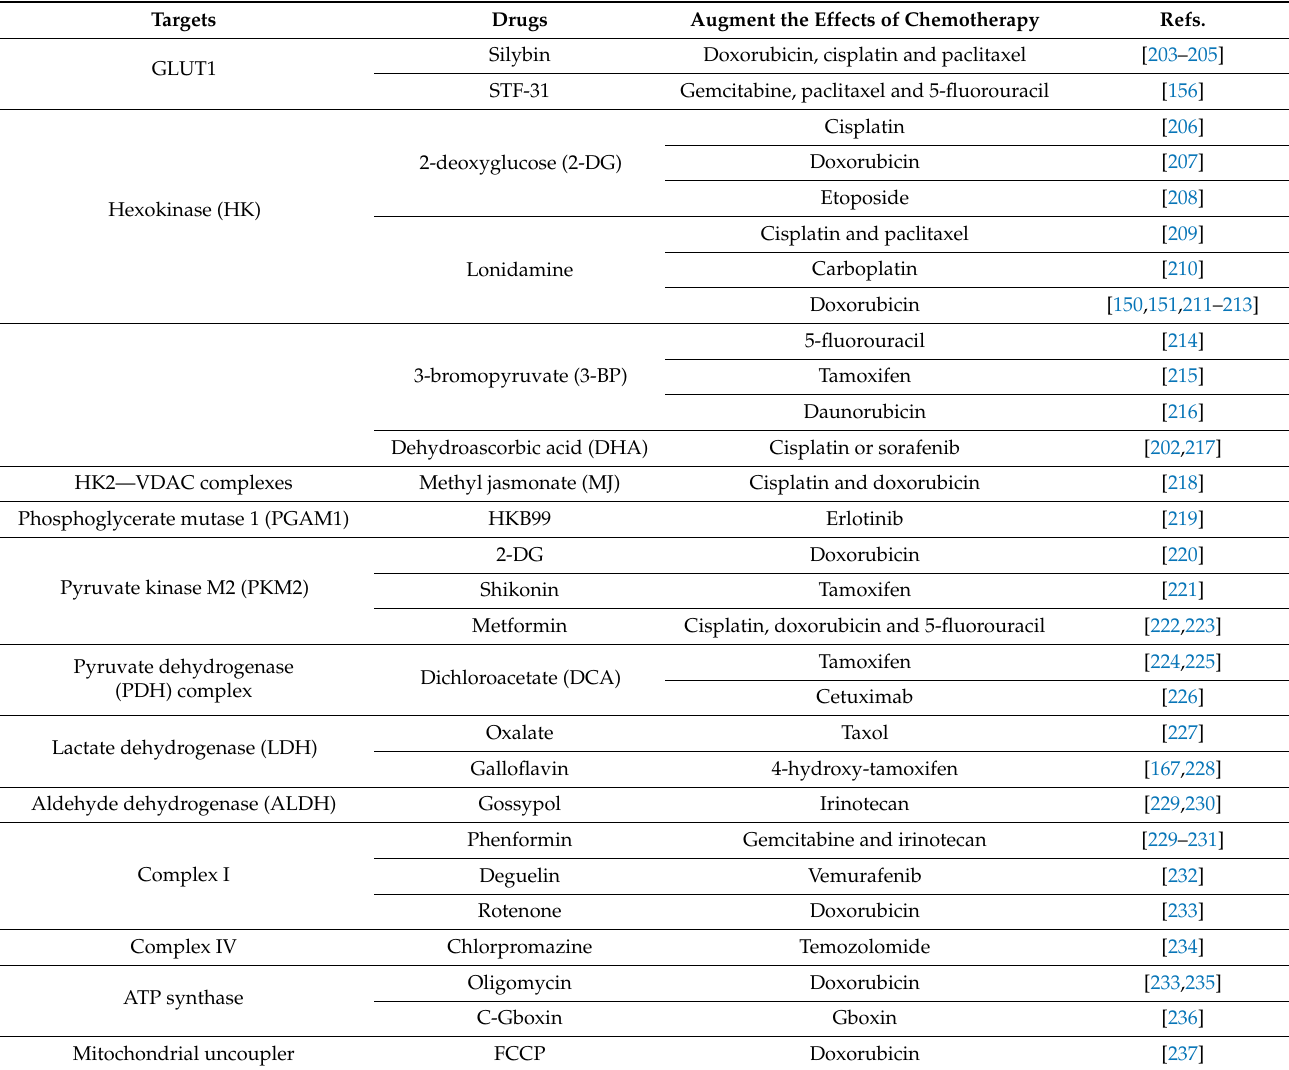
Table 1. The drugs targeting glycolysis and oxidative phosphorylation (OXPHOS) to overcome different chemotherapy